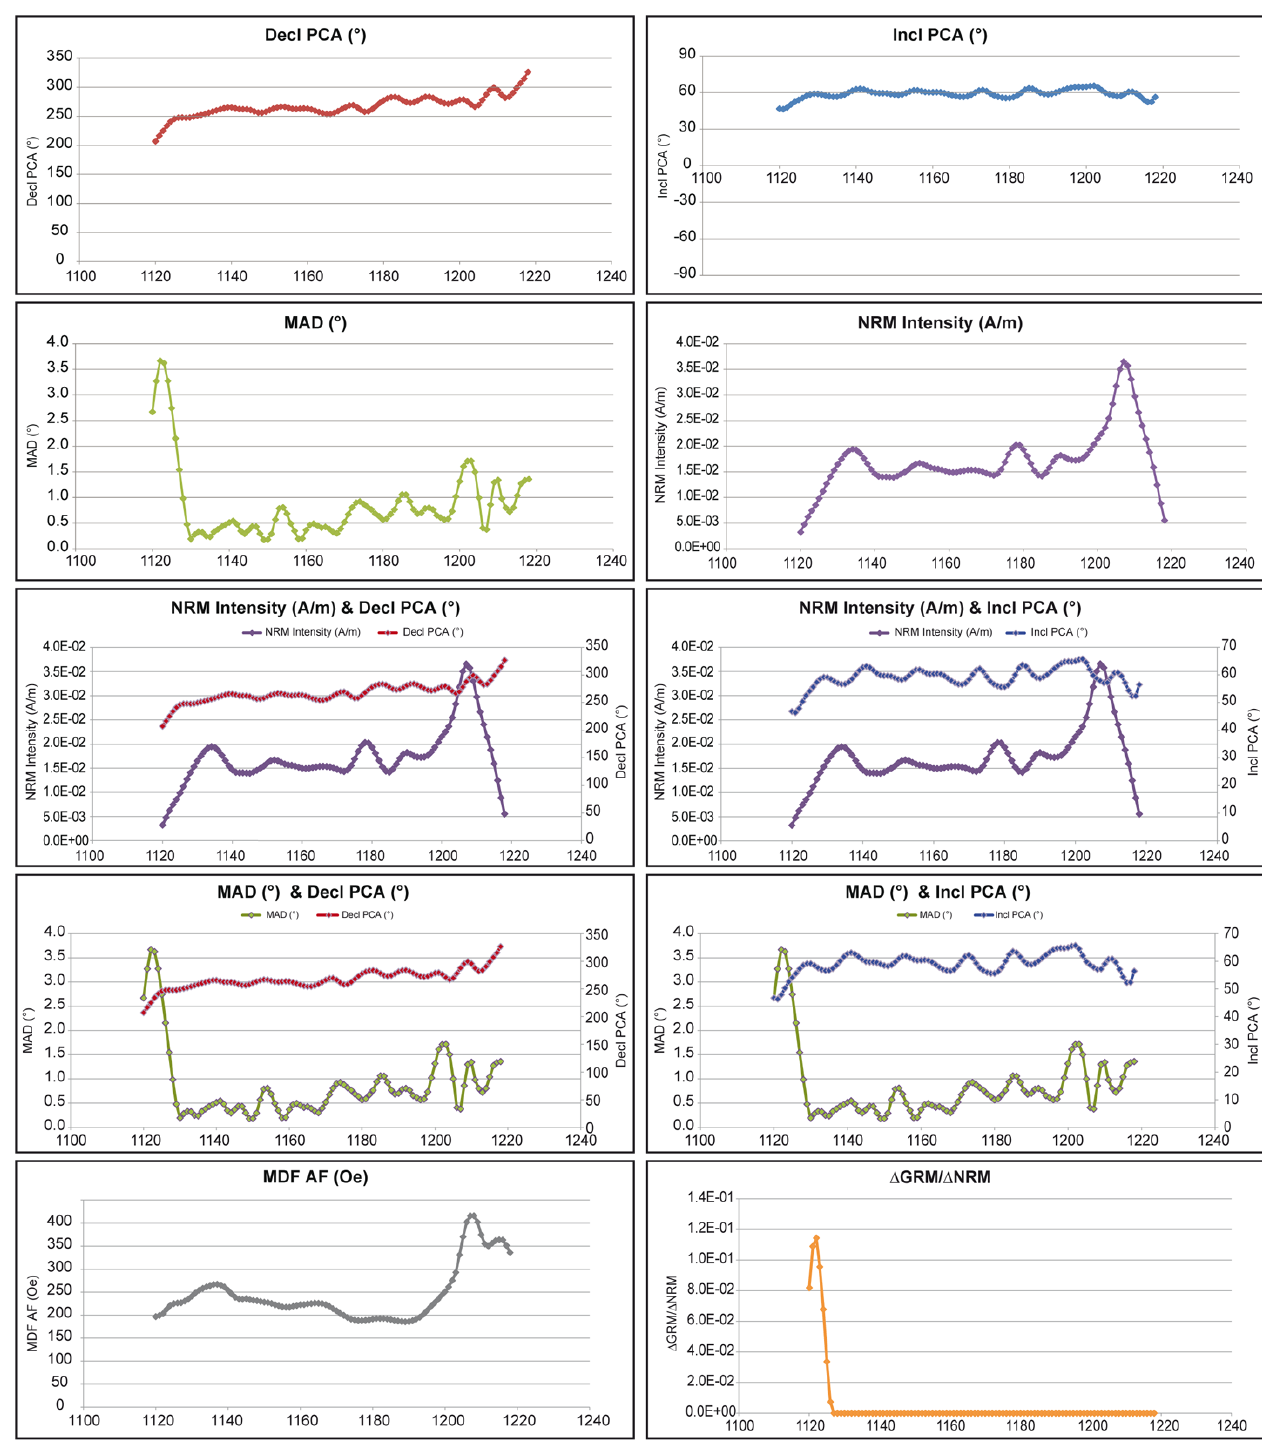
Figure 8 . The OutputPlots worksheet. This worksheet includes 10 plots showing the variation of various parameters as a function of the sample ID (or stratigraphic